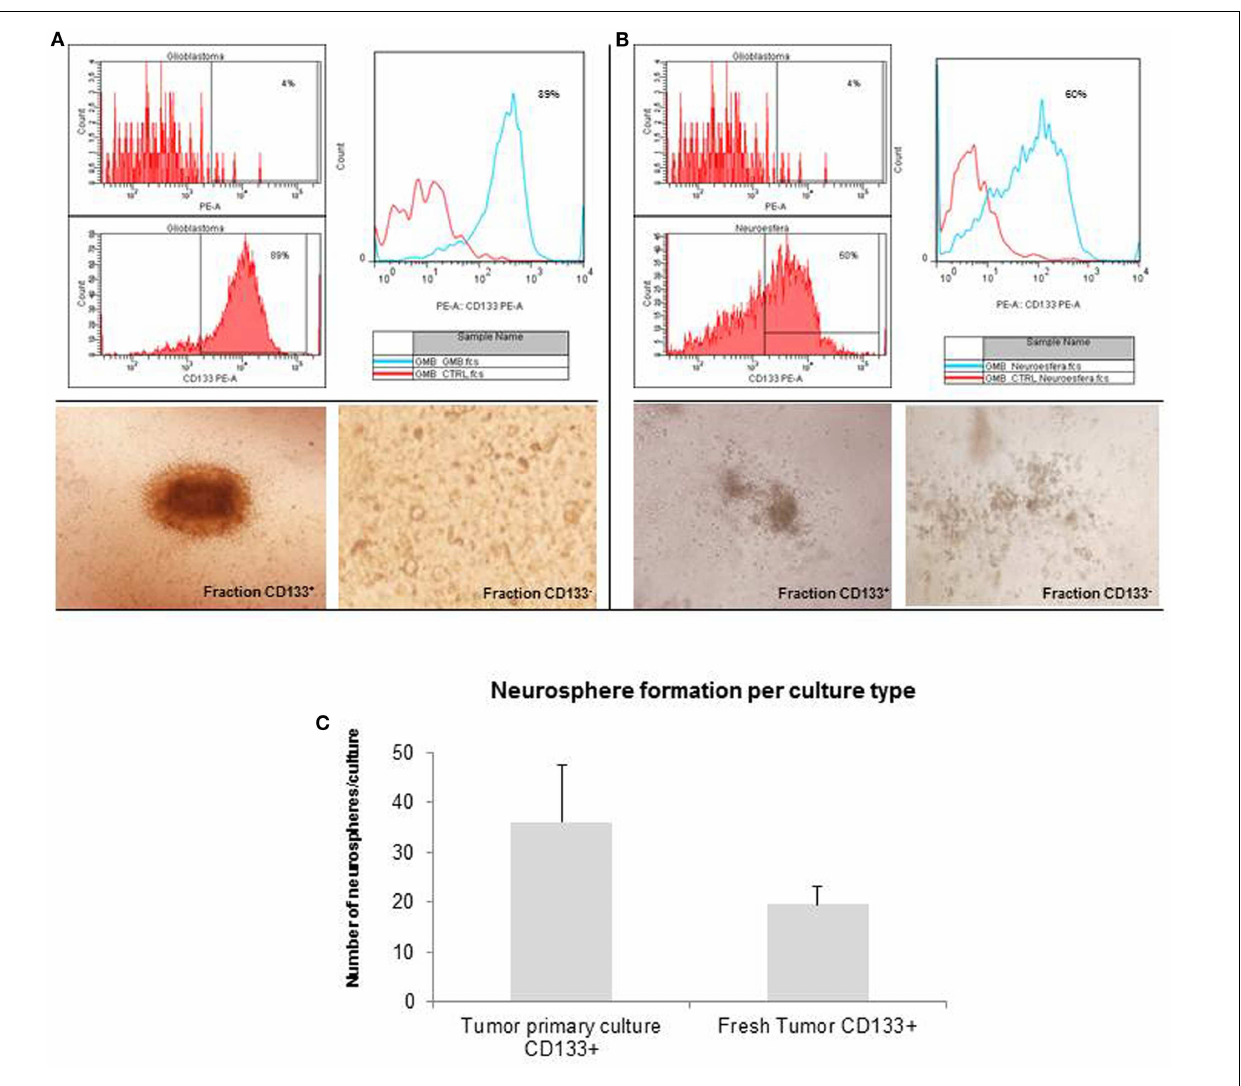
in neurospheres derived from glioblastoma primary culture were able to further generate subspheres. Culture of glioblastoma subspheres, compared with the absence of subspheres obtained from CD133 − fractions (C) . Graphic representation of neurospheres formation per culture type, such as tumor primary culture CD133 + and fresh tumor CD133 + . Representative figure of five samples of glioblastoma. Magnification: 600 ×